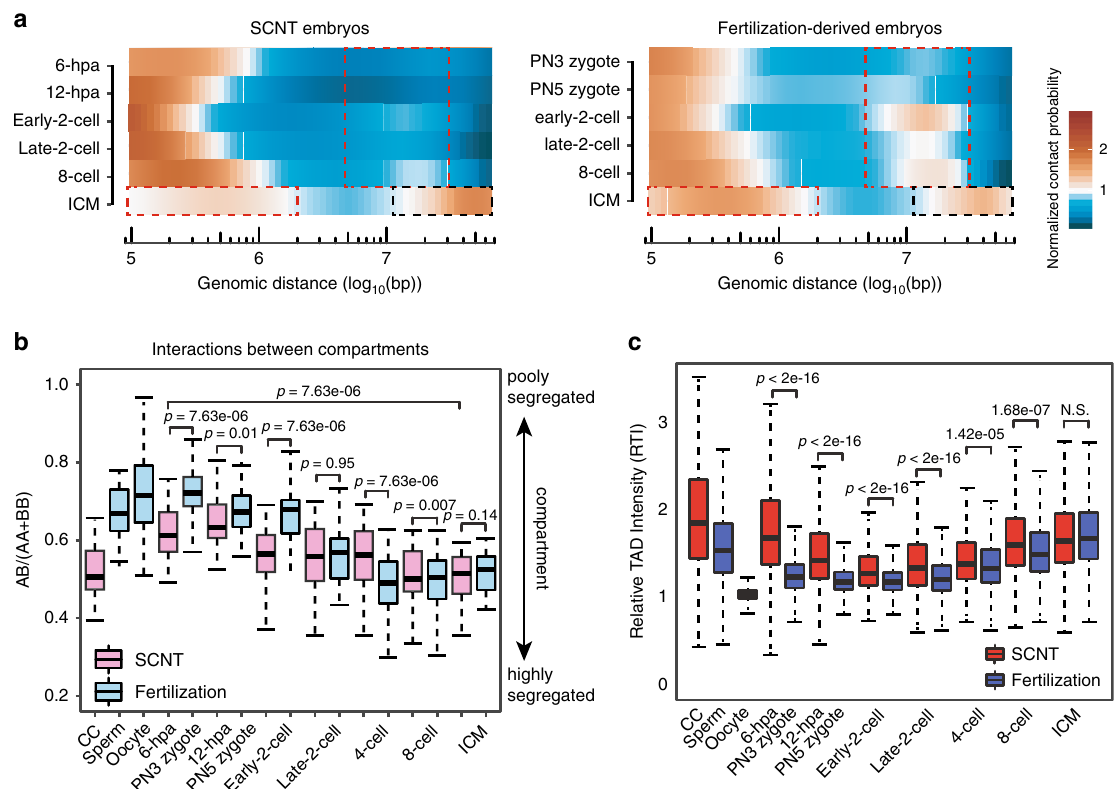
Fig. 4 Differential dynamic of chromatin structure reorganization between normal and SCNT embryos. a Heatmaps showing the intrachromosomal interaction probabilities relative to genomic distance that are normalized by the P(s) ~ s − 1 values. Dashed boxes indicate the developmental stages and genomic distance with differential interaction probabilities between SCNT and fertilization-derived embryos. Source data are provided as a Source Data fi le. b Ratios of interaction frequencies between compartments A & B to those between compartments A & A or B & B ( n = 323). Boxes show 25th, 50th and 75th percentiles and whiskers show 1.5× the inter-quartile range. The p values were calculated by a two-sided Wilcoxon rank-sum test with BH multiple testing correction Source data and exact p-value are provided as a Source Data fi le. c RTI across all stages ( n = 2057). Boxes show 25th, 50th and 75th percentiles and whiskers show 1.5× the inter-quartile range. The two-sided p values were calculated by the Kruskal – Wallis test with Dunn ’ s multiple comparison test and adjusted by default with the holm method (N.S., not signi fi cant). Source data and exact p-value are provided as a Source Data fi